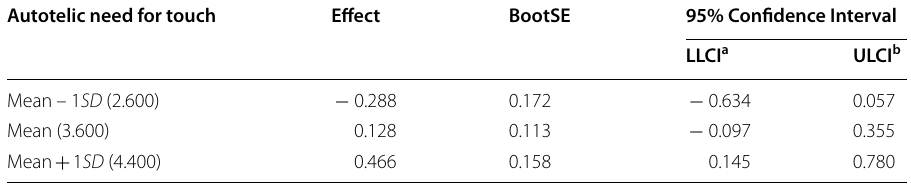
a LLCI: lower limit confidence interval b Table 4 Conditional indirect effects of touch simulation on VR store attitude at values of autotelic need for touch